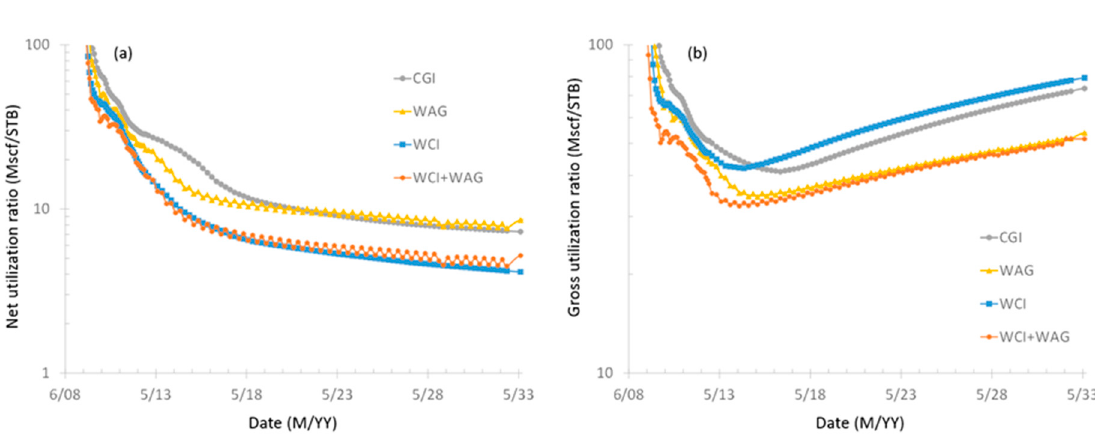
Figure 4. ( a ) Cumulative oil production as a function of CO 2 volume injected. ( b ) CO 2 storage as a function of CO 2 volume injected. HCPV = hydrocarbon pore volume.